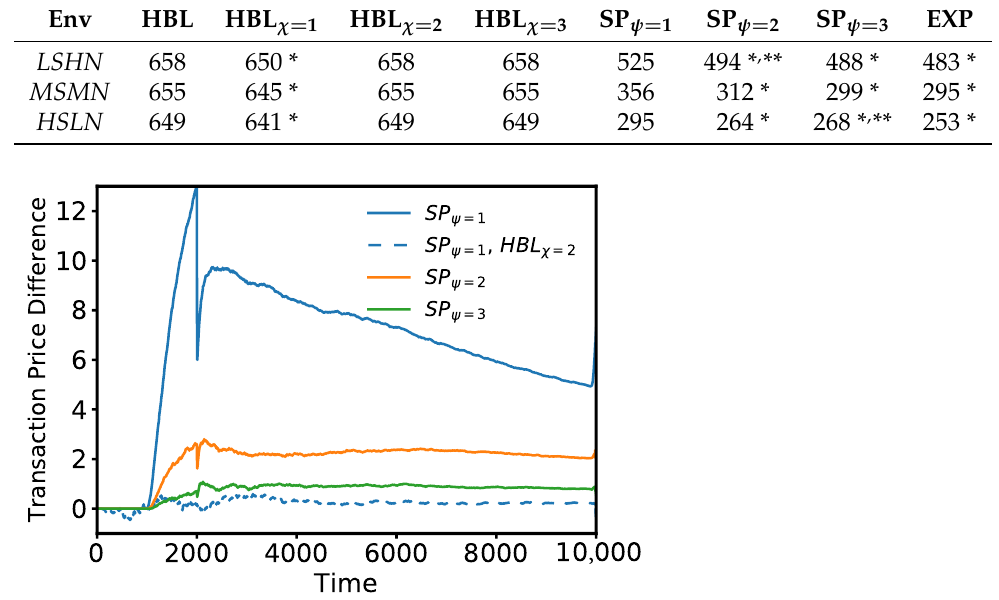
Figure 14. Price deviations caused by spoof orders placed behind different price levels in the order book. Although our exploration of possible spoofing strategies here is limited, the